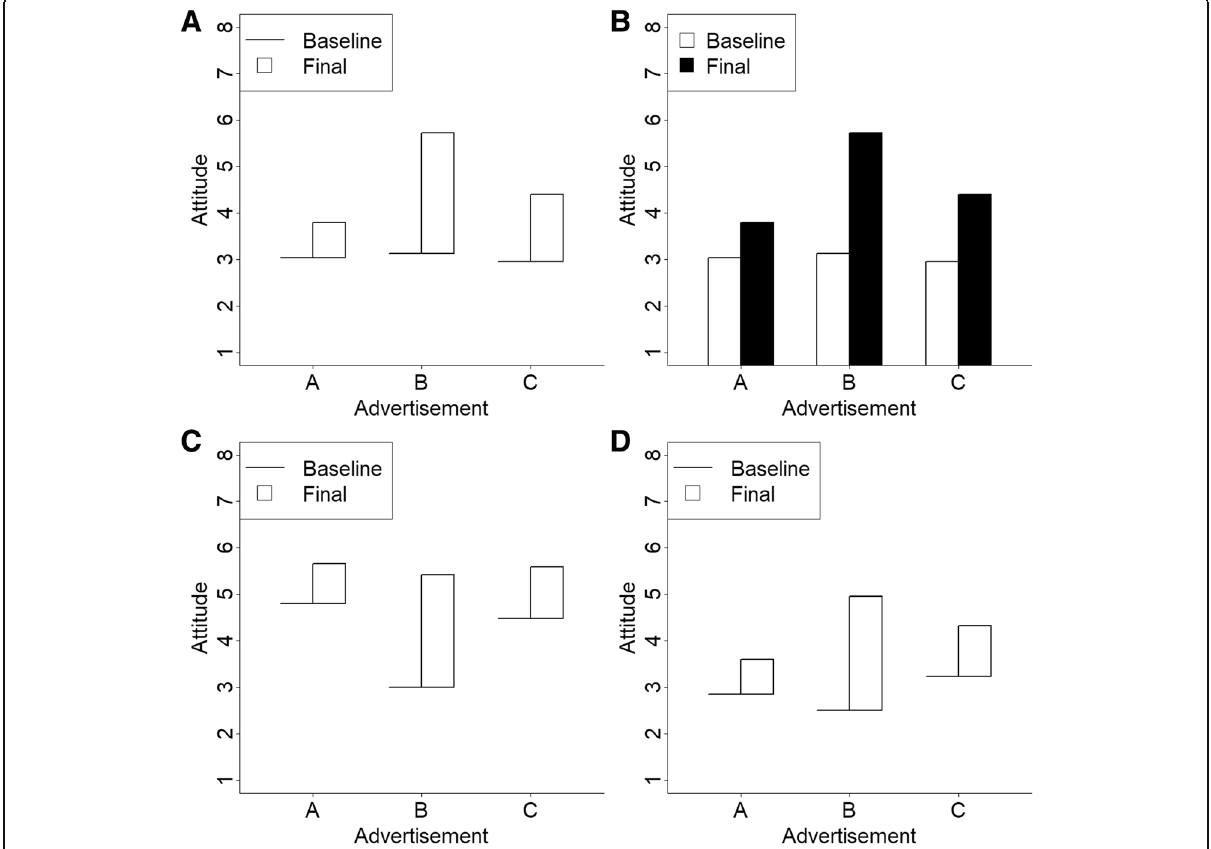
Fig. 2 Sample stimuli from experiment 1. Panels a and b show the hat graph version and the bar graph version of the same data. Panels a , c , and d show the three types of alignment (baseline, final, mean,